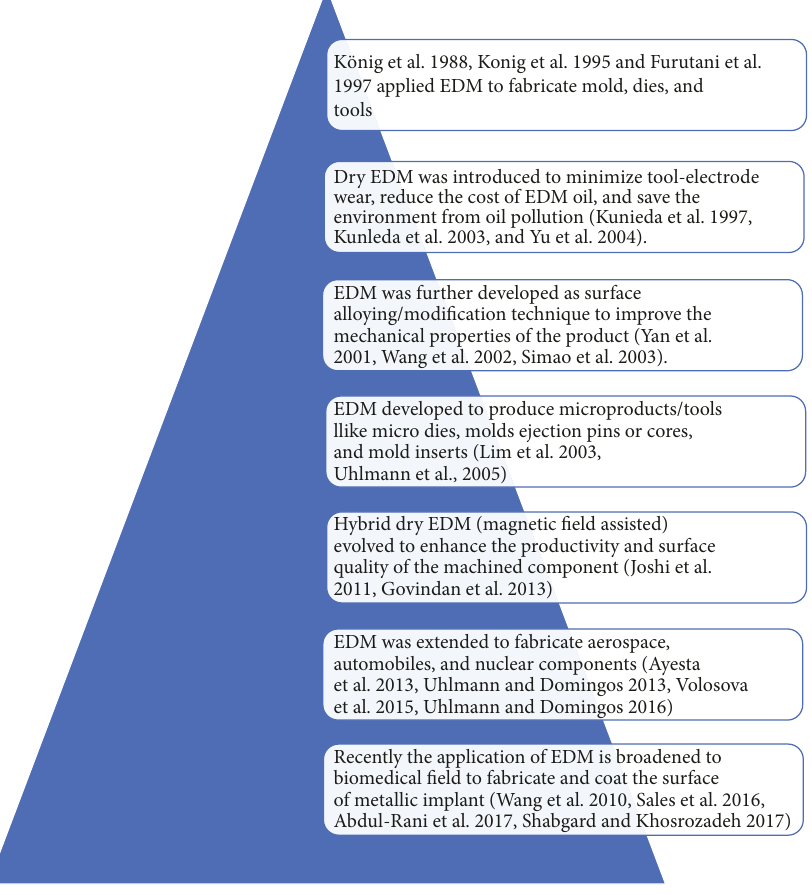
Figure 11: EDM process advancement based on